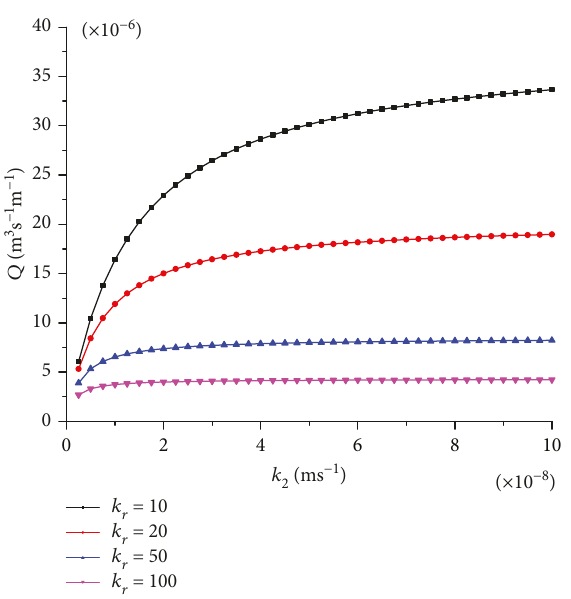
Figure 13: Relationship between the karst water fl ow and permeability coe ffi cient of the grouting